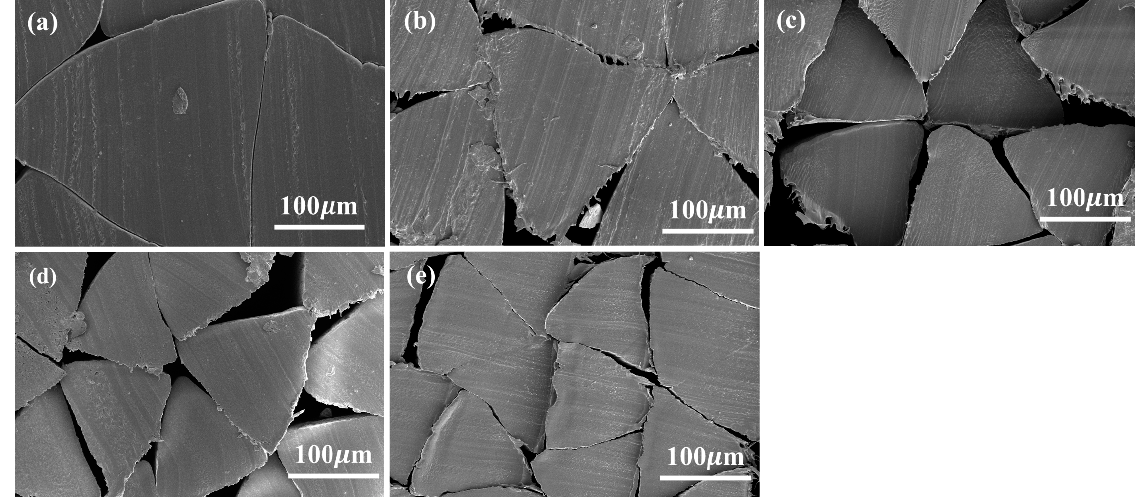
Figure 4. SEM images of the cross-section of triangular PVA fibers with different draw ratios: ( a ) 0; ( b ) 2; ( c ) 4; ( d ) 6; ( e ) 7.